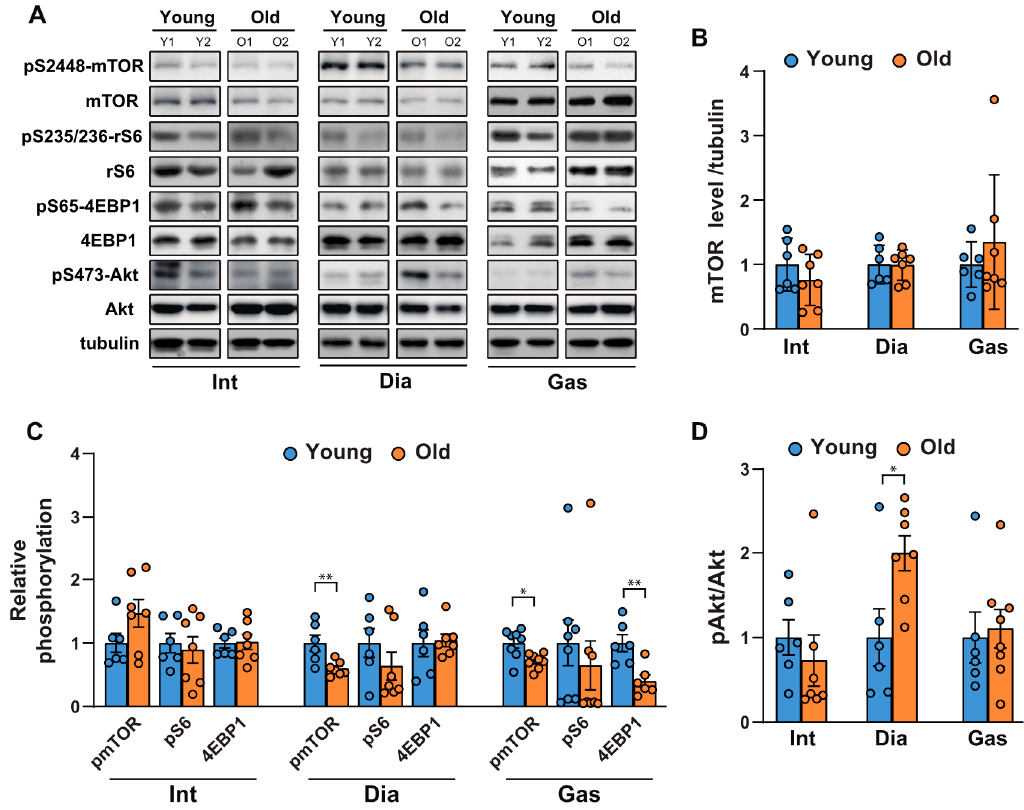
Figure 1. Comparison of the age-related changes in activities of mTORC1 and Akt in the respiratory muscles and gastrocnemii. ( A ) Each muscle was lysed, and Western blot analysis was performed ( n = 6). ( B – D ) The relative intensities of the bands were quantified using ImageJ analysis software ( n = 6). ( B ) Data are presented for mTOR compared to tubulin, ( C ) pSer2448-mTOR compared to mTOR, pSer235 / 236-ribosomal S6 compared to ribosomal S6, pSer65-4EBP1 compared to 4EBP1, and ( D ) pS473-Akt compared to Akt. The data are shown as the mean ± standard deviation. Statistical analysis was performed using unpaired Student’s t-test. * p < 0.05; ** p < 0.01; 6-month-old versus 20-month-old rat muscles. Abbreviations: diaphragm muscle (Dia); gastrocnemius muscle (Gas); intercostal muscle (Int); 6-month-old rat (Young); 20-month-old rat (Old).